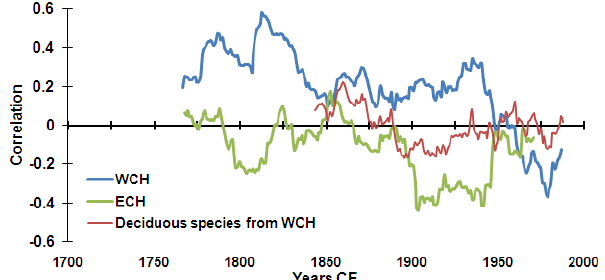
Figure 4. Low-frequency correlations between regional cryospheric dynamics and hydroclimate. Blue line indicates 51-year moving correlations between reconstructed glacier mass balance (GMB) and regional tree-ring δ 18 O (Manali, Uttarakashi, and Jageshwar) from western part of the central Himalaya (WCH). The abrupt phase shift since the 1960s is peculiar for the WCH. Green line indicates 51-year moving correlations in the eastern central Himalaya (ECH) between annual snow accumulation from the Dasuopu ice core (Thompson et al., 2000) and regional δ 18 O (Ganesh and Bhutan), while the red line indicates 51-year moving correlations between GMB and tree-ring δ 18 O of a dominant deciduous species ( Aescu- lus indica ) growing in the WCH. Its similarity in coherence to that of the ECH is remarkable and illustrative of the summer monsoon influence during the annual growing period